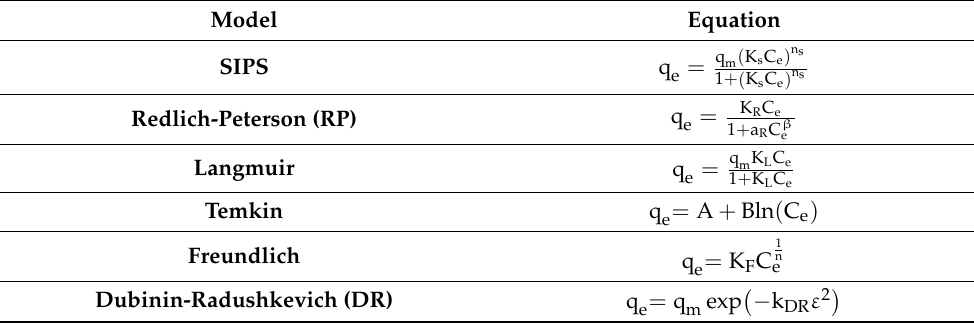
Table 1. Non-linear adsorption isotherm models